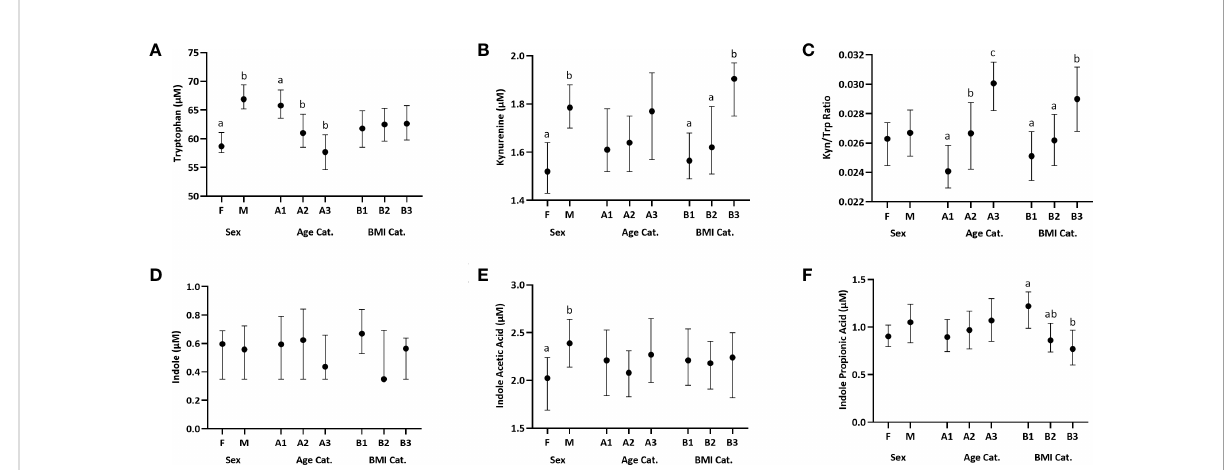
FIGURE 1 Distribution of plasma Trp and Trp metabolites across females (F) and males (M), three age categories (Cat.), A1-A3: [18 – 34 y (n=129), 35 – 49 y (n=119), and 50 – 66 y (n=114)] and three BMI categories, B1-B3: [18 – 24.99 kg/m 2 (n=139), 25.00 – 29.99 kg/m 2 (n=131), and 30.00 – 44 kg/m 2 (n=92)]. Data are presented as medians, and 5th and 95th percentiles. Signi fi cant differences between groups within the sex, age and BMI categories are marked by different letters. (A) Trp, (B) Kynurenine, (C) Kynurenine : Tryptophan (Kyn/Trp) ratio, (D) Indole, (E) Indole Acetic Acid, (F) Indole Propionic